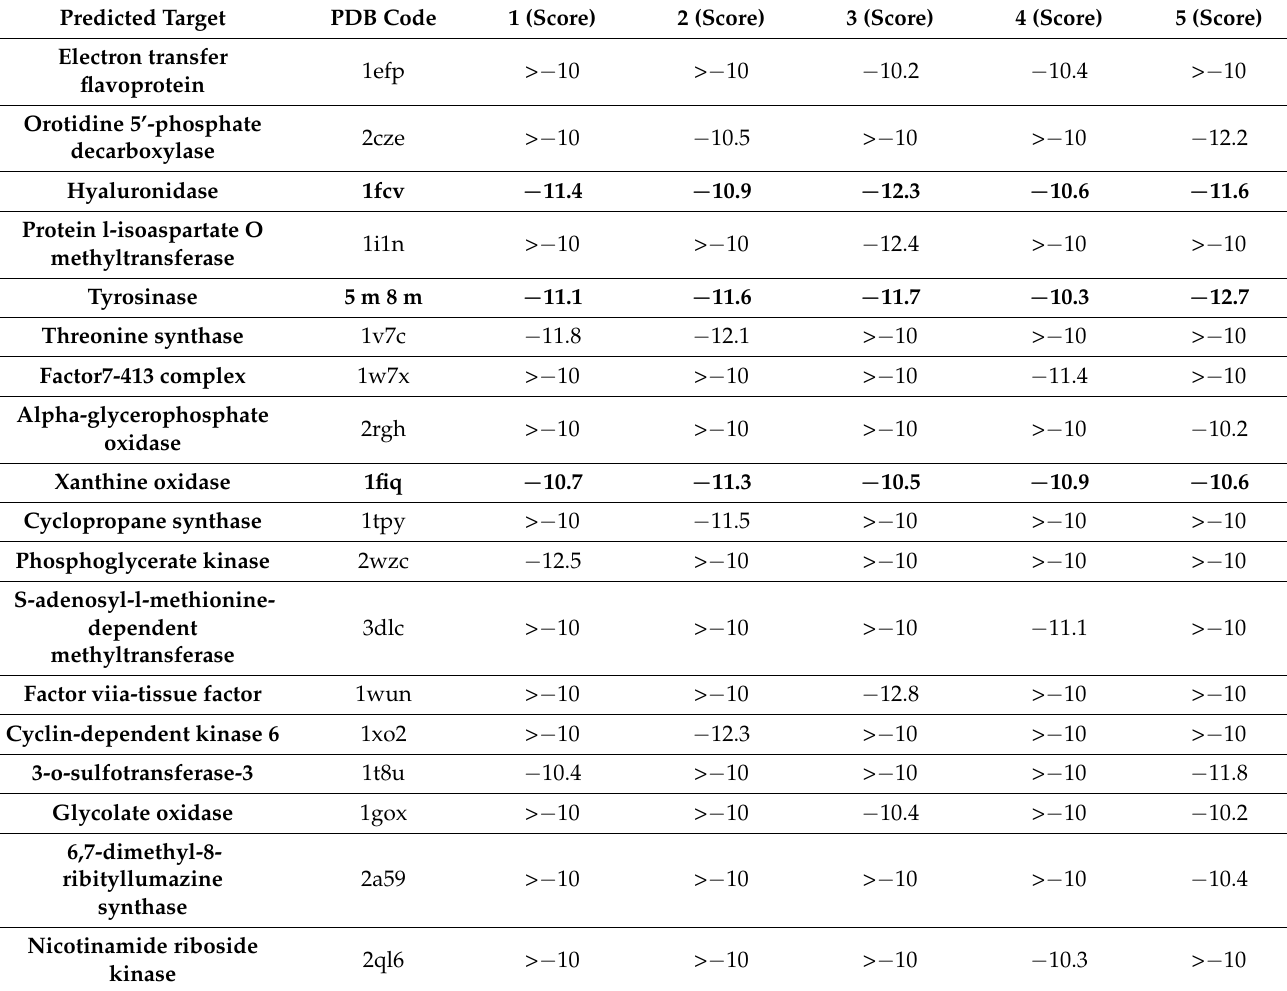
Table 1. Inverse docking results of compounds 1 – 5 . Binding scores were calculated as kcal/mol. A cut-off value of − 10 kcal/mol were set to choose the best protein targets for each